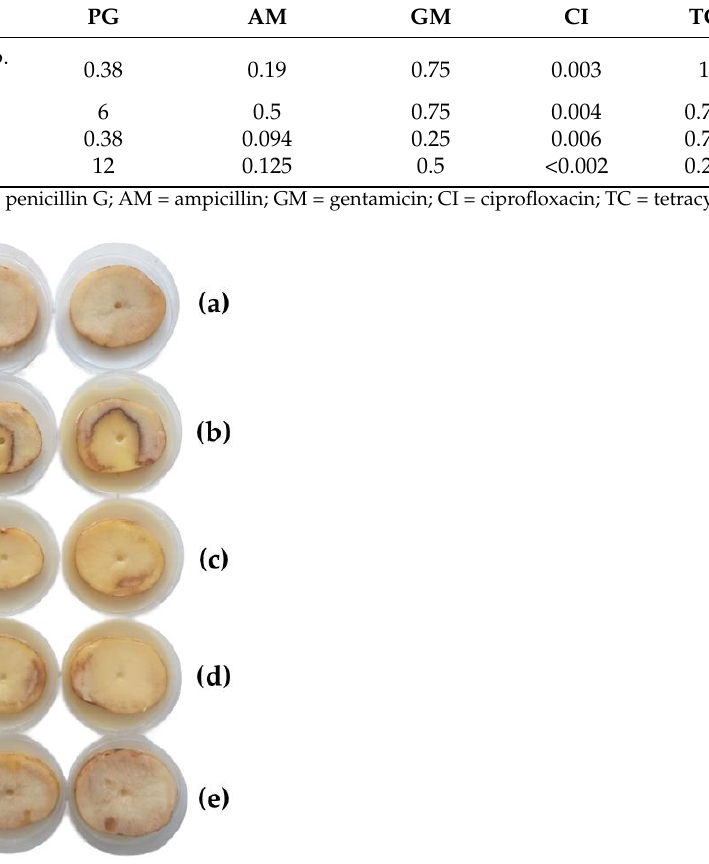
Table 3. Minimum inhibitory concentrations of conventional antibiotics (for clinical use) against soft rot Pectobacteriaceae (SRP) (expressed in µ g · mL − 1 ). Bacteria PG AM GM CI TC P. carotovorum subsp. 0.38 0.19 carotovorum